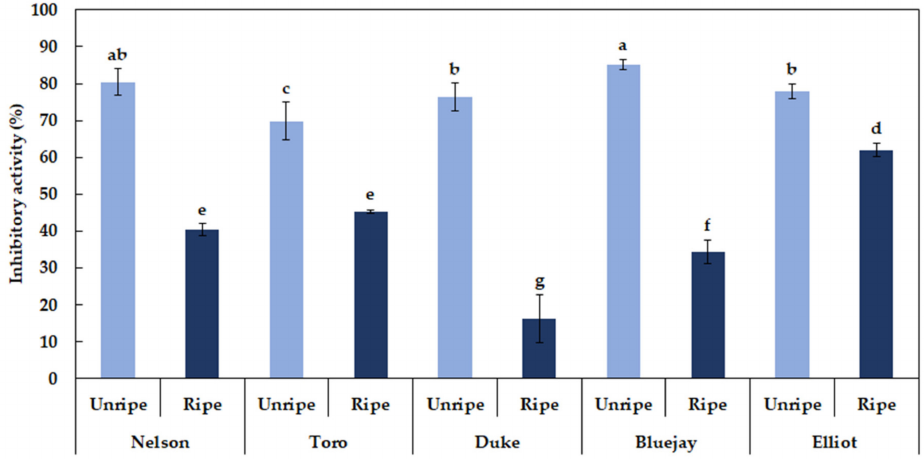
Figure 3. Di ff erent letters ( a – g ) are significant di ff erences by Duncan’s multiple range test ( p < 0.05).